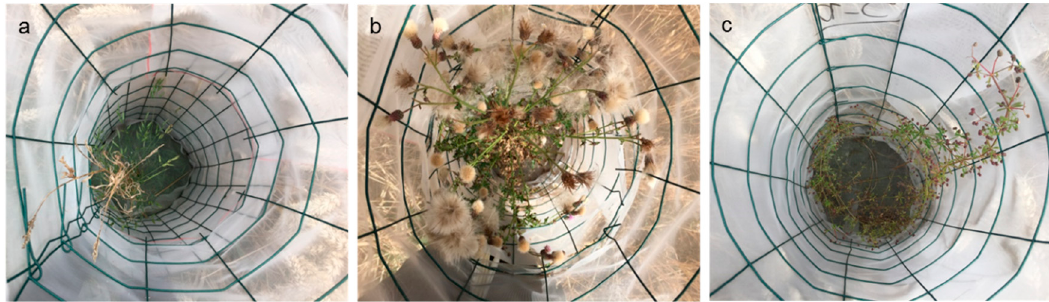
Figure 1. A plant of ( a ) Bromus hordeaceus , ( b ) Cirsium arvense, and ( c ) Galium aparine in nets to record seed shedding during the growing season of winter wheat.